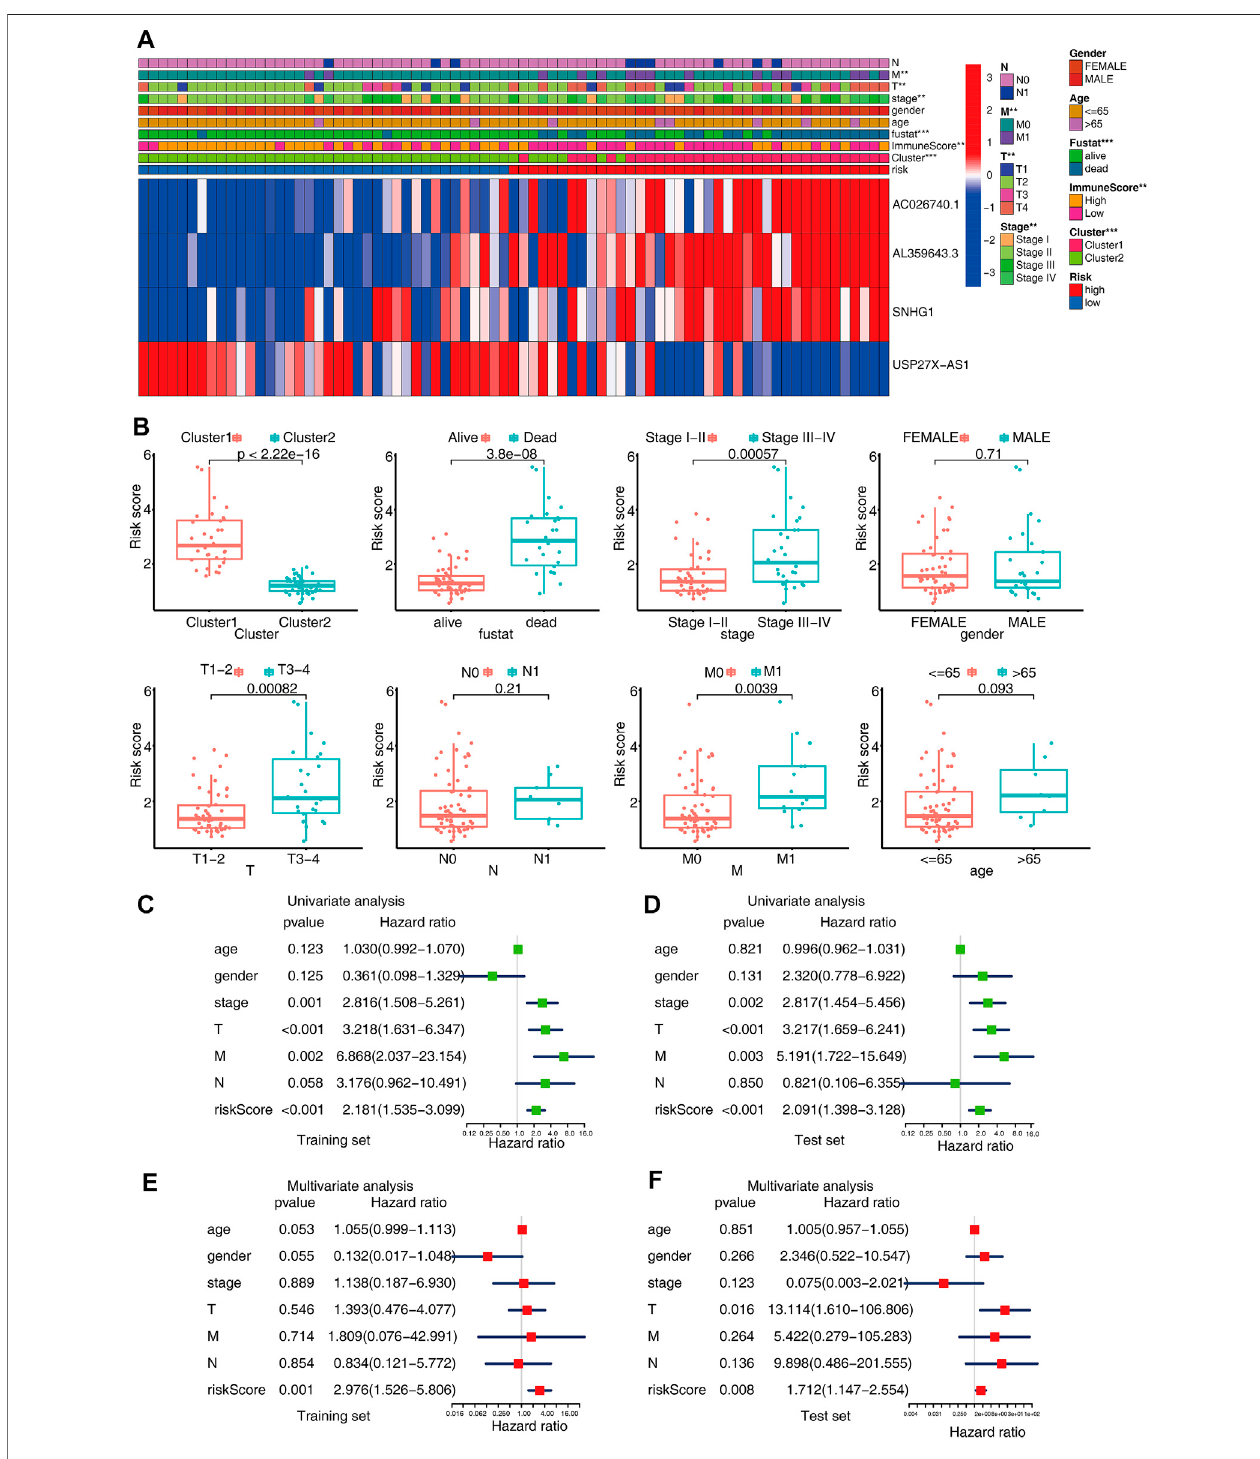
FIGURE5|(A) Heatmapshowstherelationshipbetweentheexpressionlevelsofthefourselectedm6A-relatedlncRNAsandclinical-pathologicalcharacteristicsin ACC. (B) Boxplots showing the distinct risk scores between patients having various clinical-pathological characteristics (such as cluster, stage, gender, and TNM categories). (C,D) Univariate analysis shows that risk independently serves asa prognostic indicator in both training and test sets. (E,F) Multivariate analysis reveals that the risk score independently serves as a prognostic indicator in both the training and test sets.